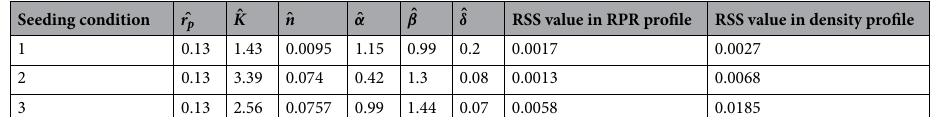
Table 2. Estimated model parameters from density-RPR fitting of our model.